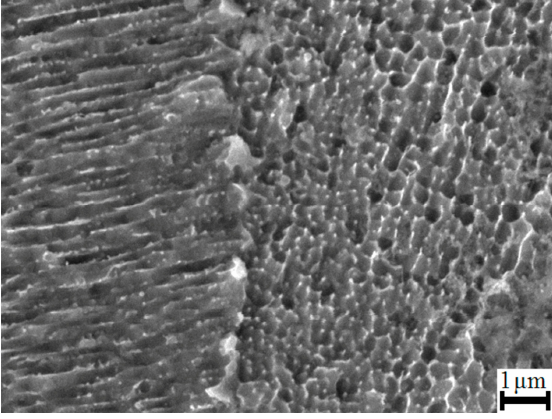
Figure 6. SEM image of SLM sample with dendritic structure and cellular structure.